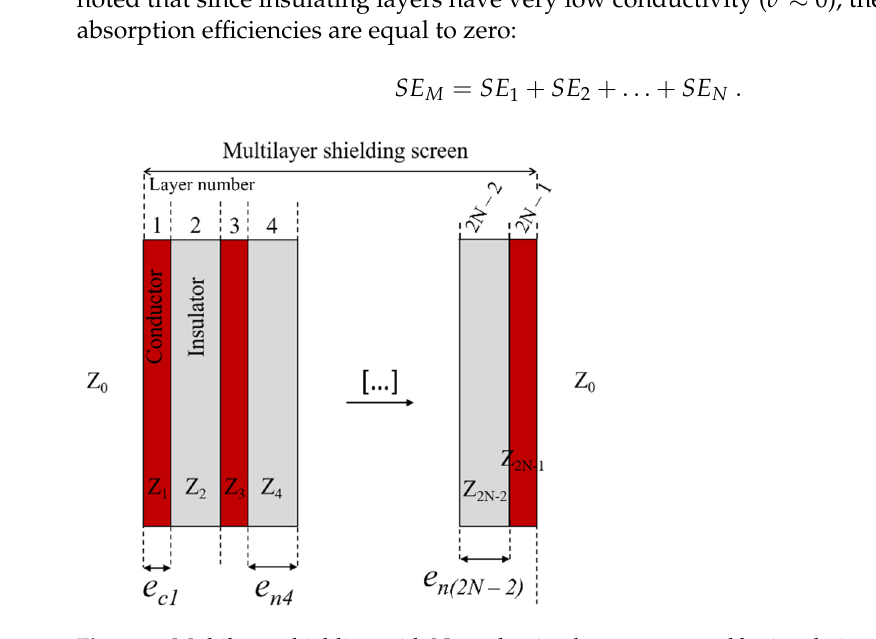
Figure 4. Multilayer shielding with N conducting layers separated by insulating layers.